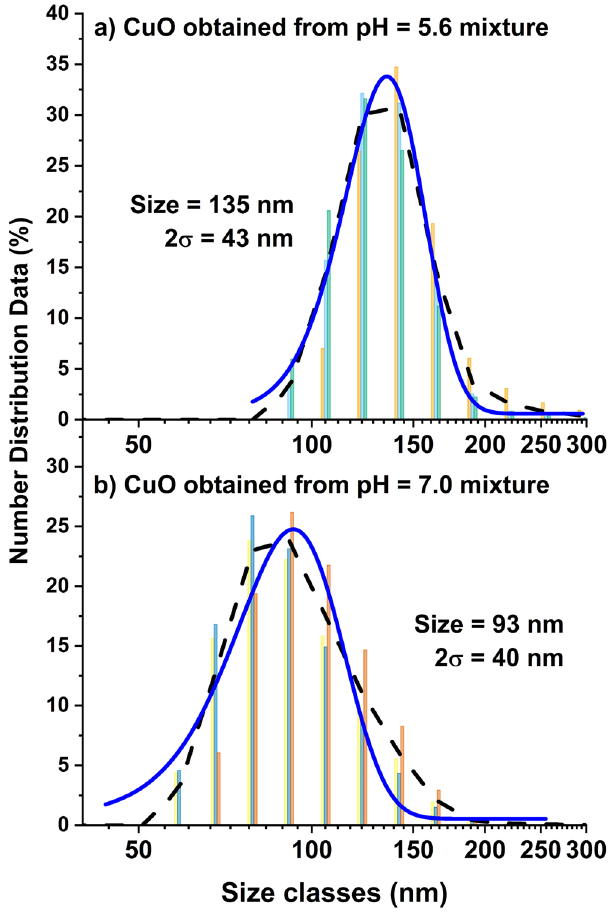
Figure 7. Size distributions of CuO aggregates synthesized at ( a ) at pH = 5.6 and ( b ) pH = 7.0, as measured by DLS. The synthesized CuO nanopowders were dispersed in a water-based solution with 0.5% sodium dodecyl sulfate (SDS) using ultrasound waves and subsequently measured by DLS. Colored bars indicate single measurement; black line is the average of these measurements and blue line is the Gaussian fit of the average